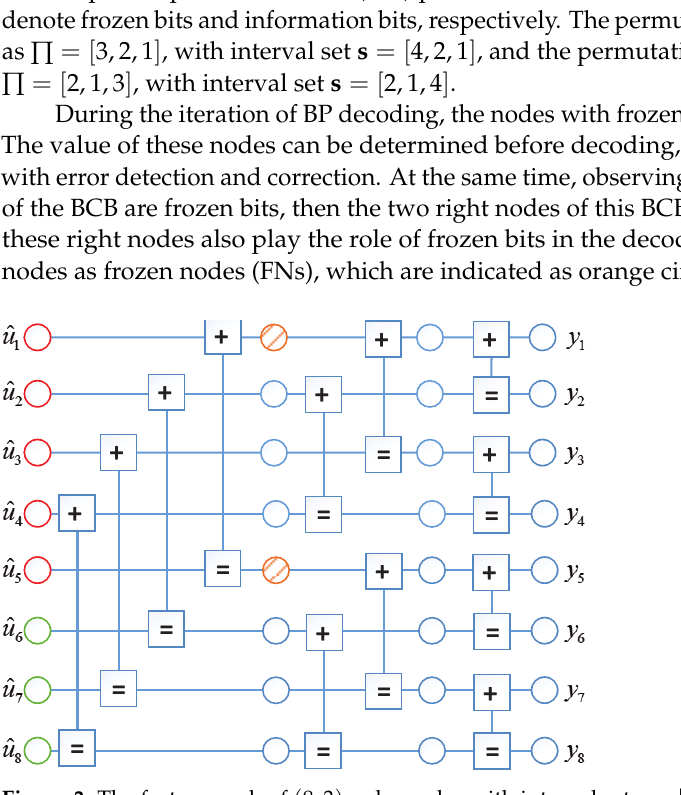
Figure 3. The factor graph of ( 8,3 ) polar codes with interval set s = [ 4,2,1 ]